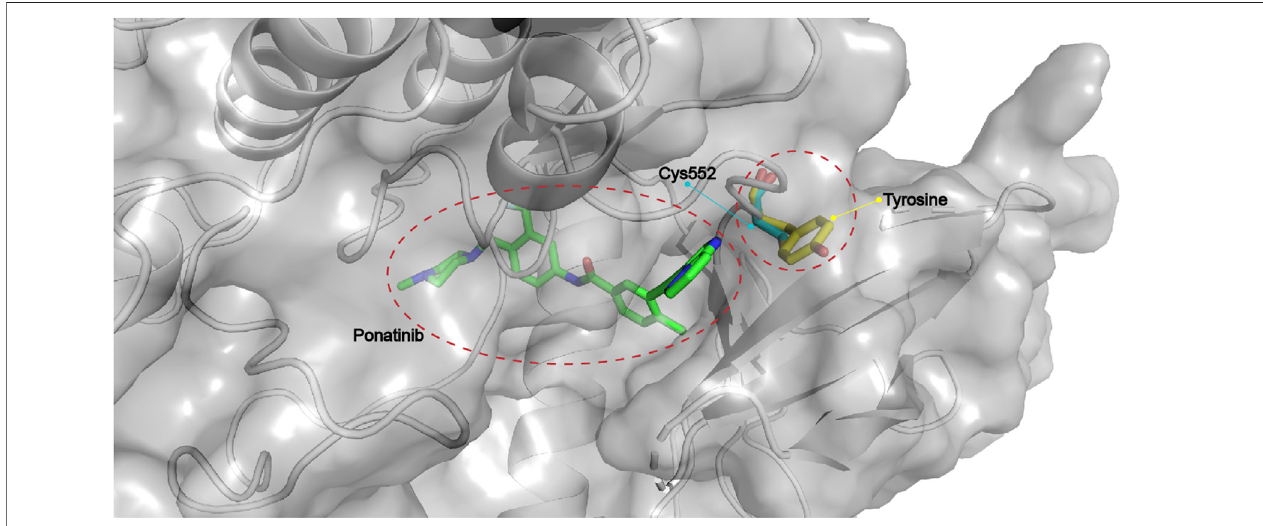
FIGURE 11 | Critical Cys552 in FGFR4 and replacement by tyrosine in FGFR1-3 (PDB: 4QRC, the crystal structure of FGFR4 in complex with Ponatinib).